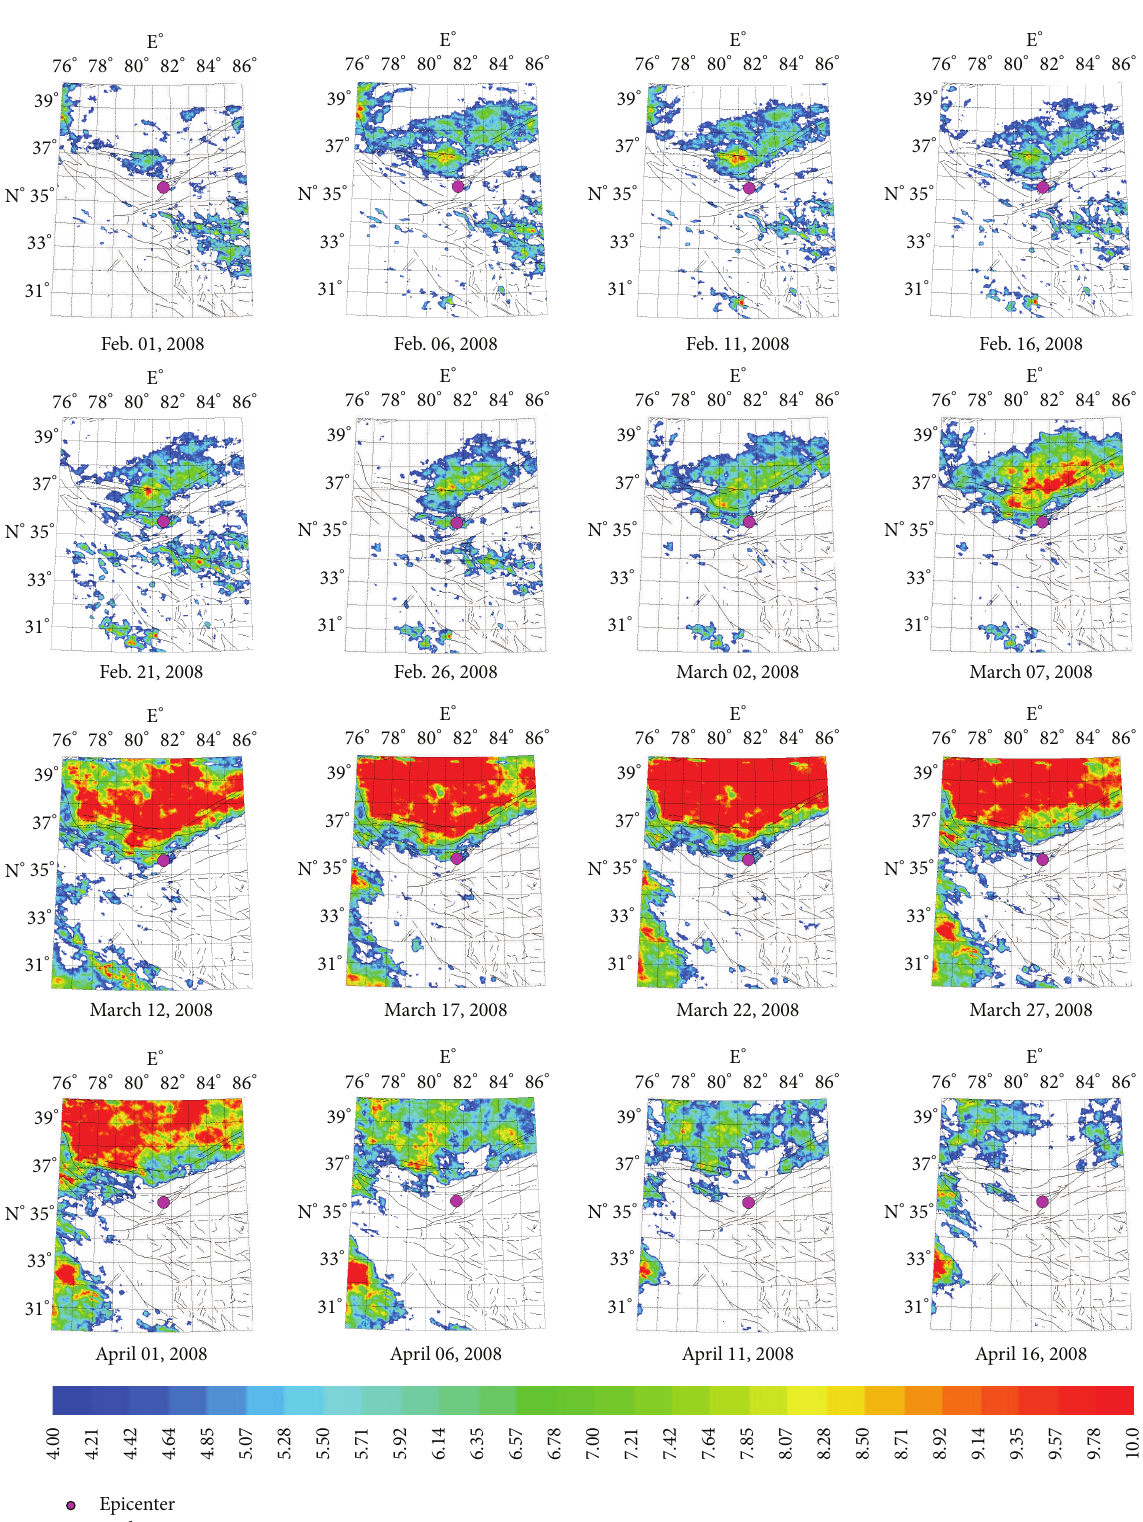
Figure 5: Space-time evolution of Yutian Ms 7.3